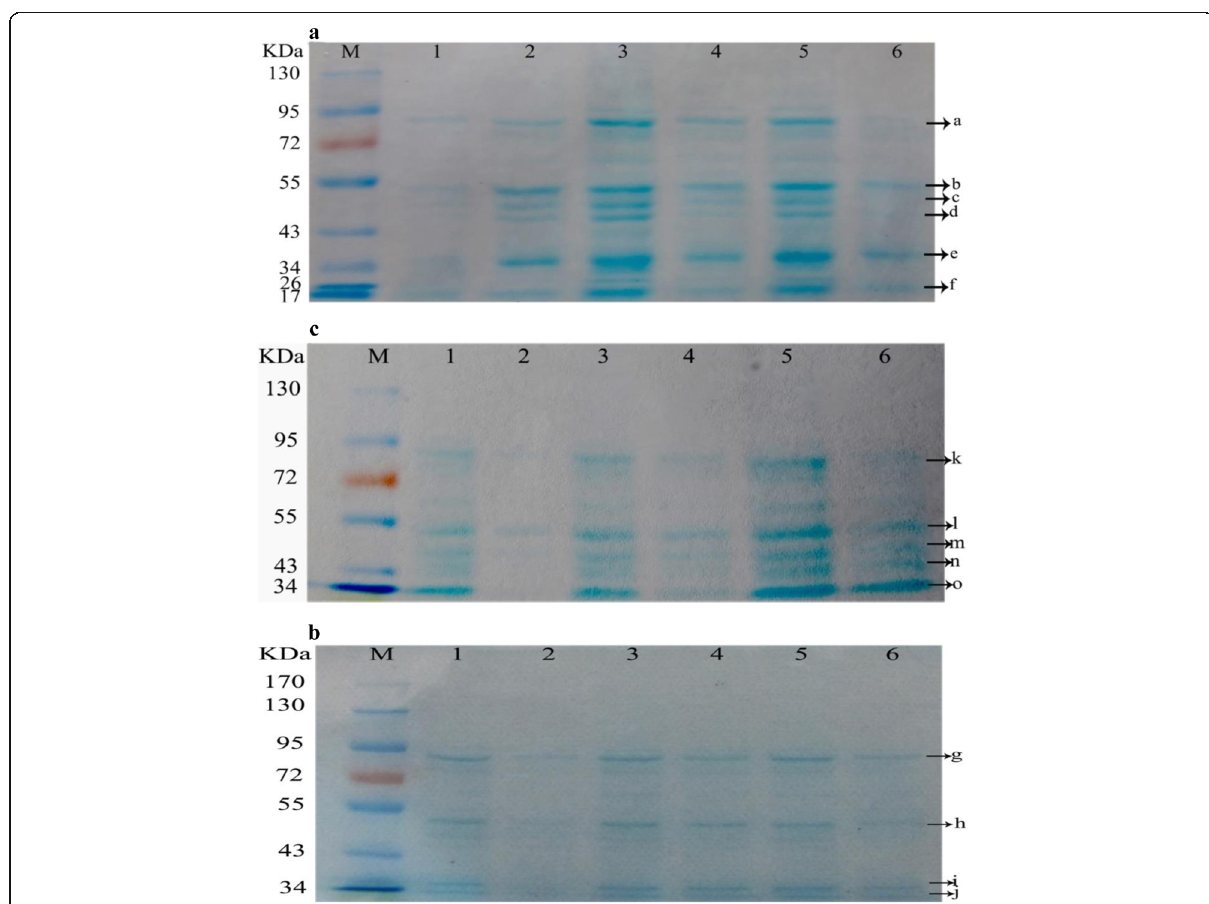
Fig. 4 Changes in SDS-PAGE profiles of SA ( a ), MRSA ( b ) and ESBLs-SA ( c ) affected by chelerythrine. Lanes 1, 3 and 5: Normal electrophoretic bands of SA, MRSA, and ESBLs-SA for 3 h, 6 h, 9 h respectively(control groups); Lanes 2, 4, 6: Electrophoretic bands of SA, MRSA, and ESBLs-SA affected by chelerythrine treatment for 3, 6 and 9 h,